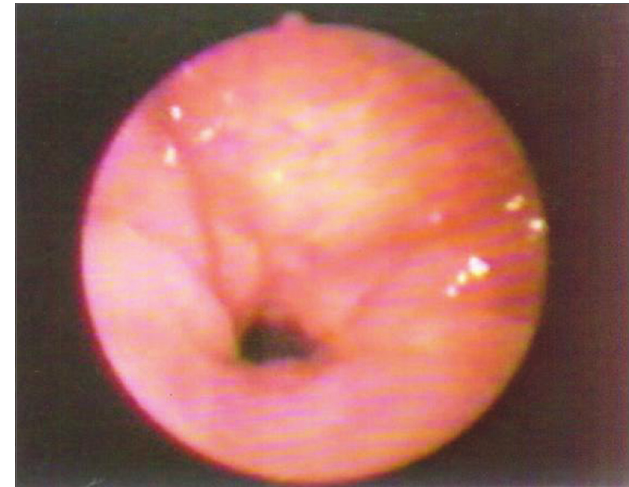
Figura 7. Paciente 4: fechamento do EVF em registro